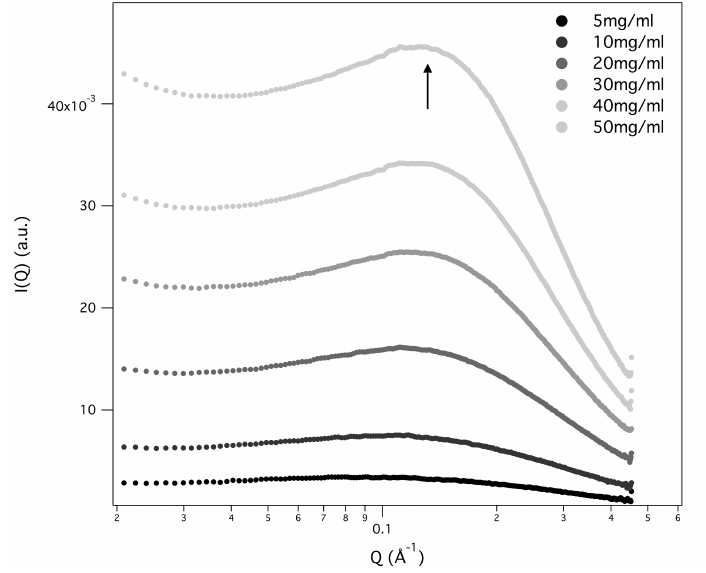
Figure 4. SAXS profiles for GMPNa 2 in pure water at 24 ◦ C. The grey color of the lines is related to GMP concentration, as in the legend. The arrow indicates the observed correlation